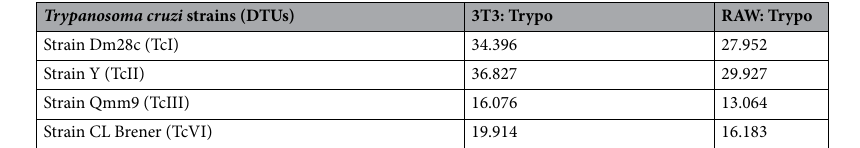
Table 2. Selectivity index (SI) of diethyldithiocarbamate in different strains in trypomastigote form of Trypanosoma cruzi after 24 h of cultivation Different forms of T. cruzi epimastigote (Epi) and trypomastigotes (Trypo) and cell lines (3T3 and RAW